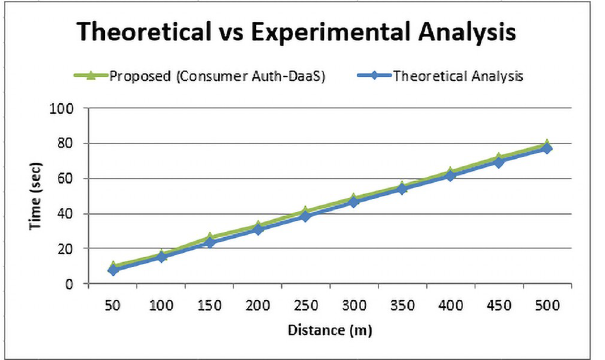
Fig 5. Time and distance relationship between the theoretical and experimental curves of the proposed Consumer-Auth